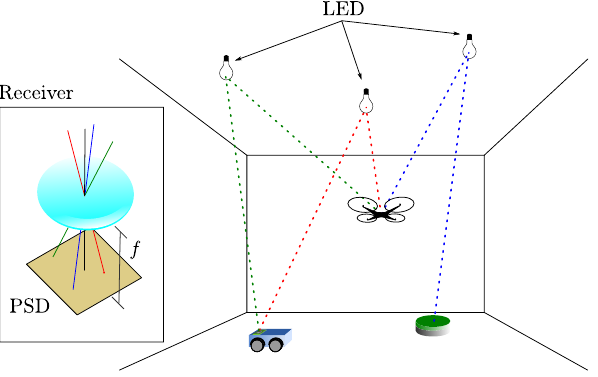
Figure 1. Scheme of the proposed positioning system.